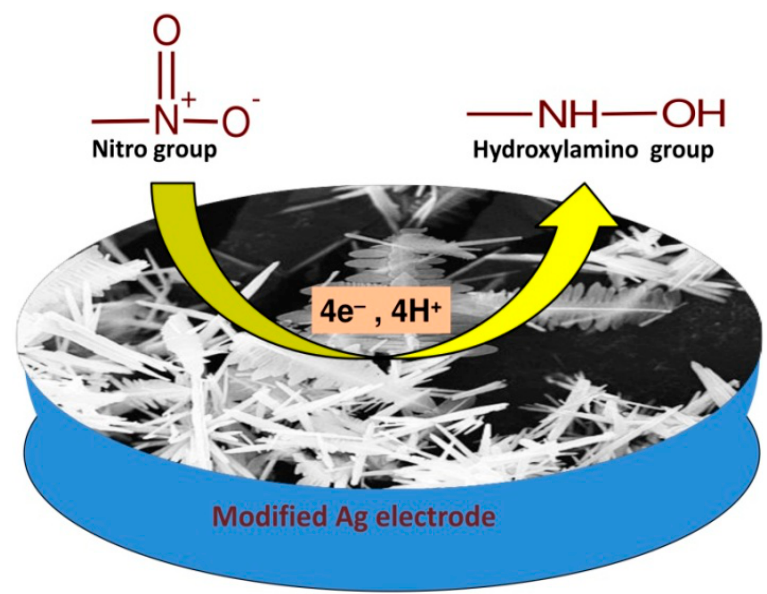
Figure 6. A schematic representation of the electrochemical sensing mechanism for the Sm 2 O 3 -doped ZnO beech fern hierarchical structures-modified AgE toward nitroaniline sensing. Adapted figure from [71] with permission from copyright (2017), Elsevier.